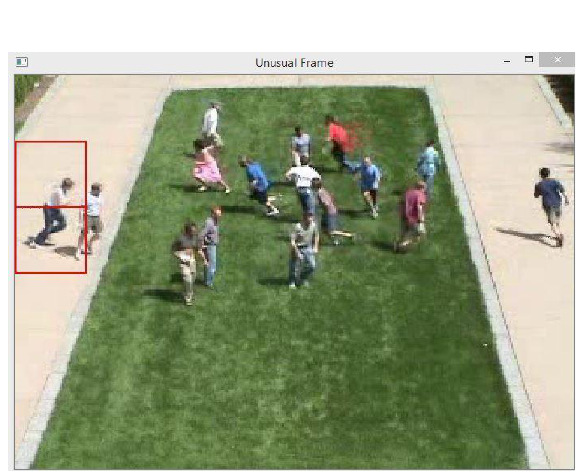
Figure 2. Some Abnormal activity is detected